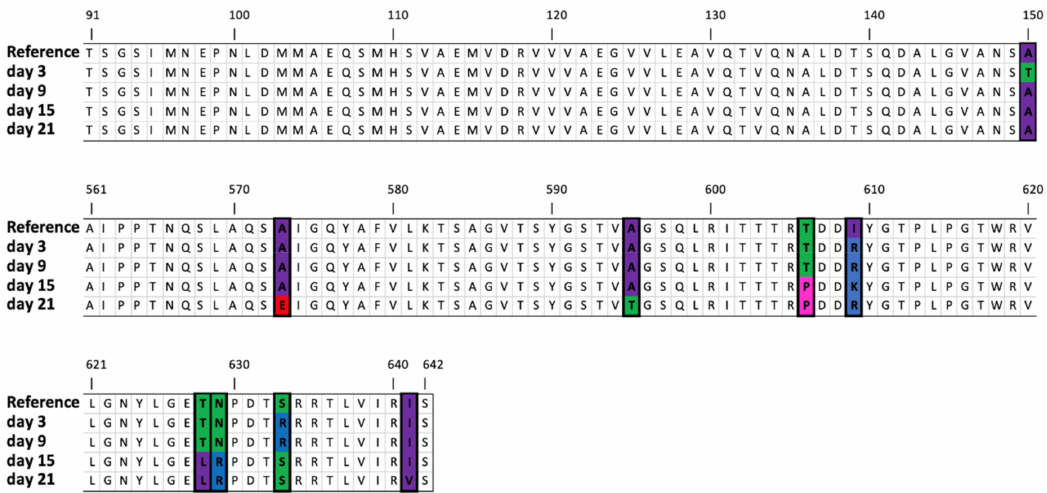
Figure 6. Amino acid sequence (91–150 and 561–642) of the tail fiber protein showing the mutations that appeared during the experiment (colored by polarity). Note: for simplicity, all mutations that occurred with more than 30% frequency at a certain time point are shown on the same protein sequence; this does not necessarily mean, however, that all the mutations occurred on the same specific protein